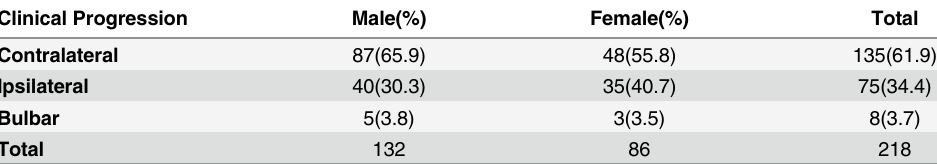
Table 2. Clinical progression in patients with Amyotrophic Lateral Sclerosis Clinical Progression